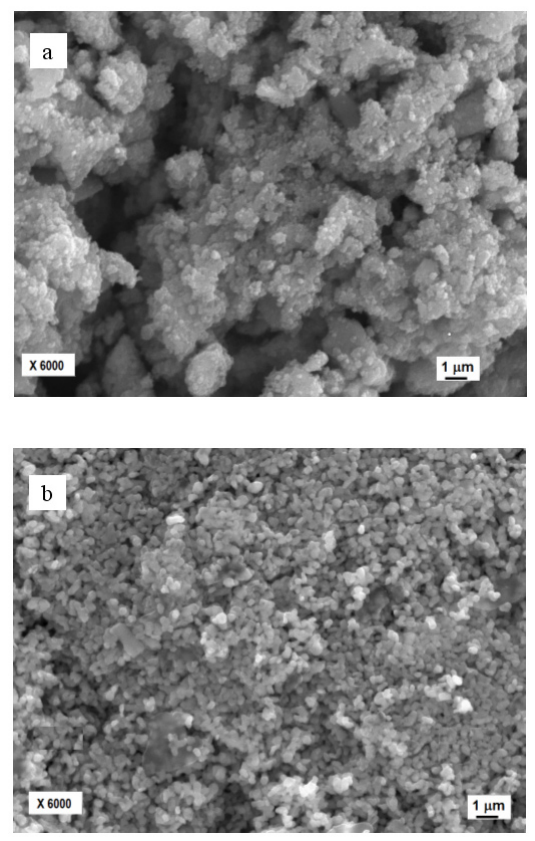
Figure 3. SEM image of the trigonal ( α ) ZrMo